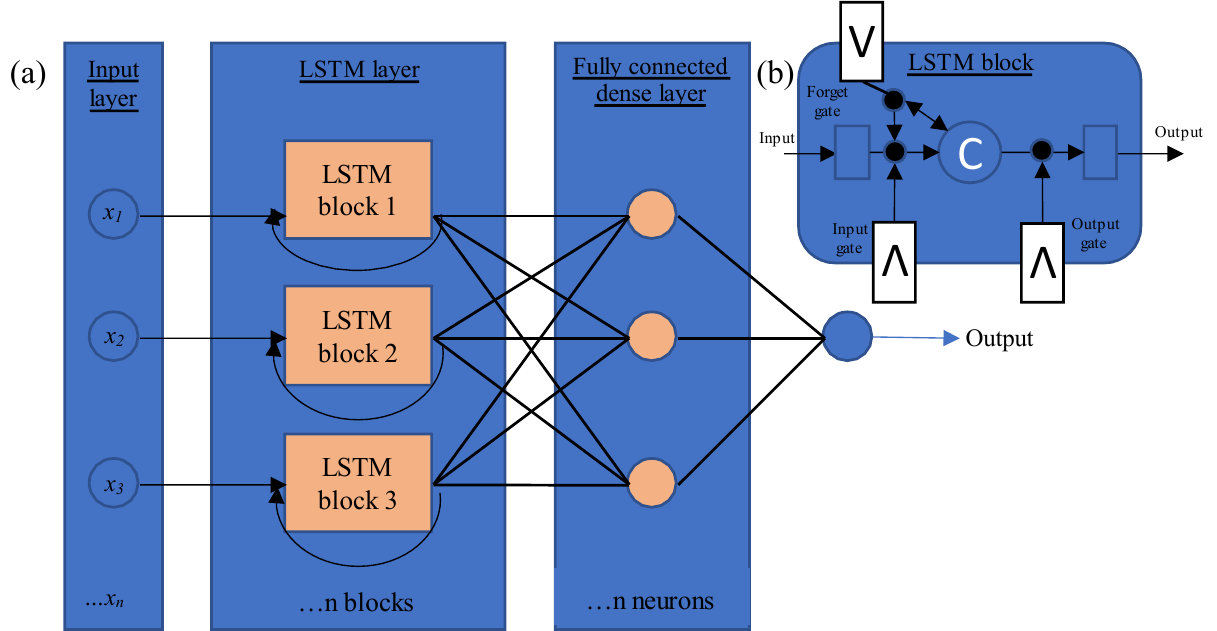
Figure 3: ( a ) simple schematic of an LSTM based architecture. Indicated is the input layer with input vectors x 1 − x n . The hidden layer is in the middle, with the LSTM blocks. Followed by a single fully connected layer providing output; and ( b ) simple internal schematic of an LSTM block. Here the input, output, and forget gates control the flow of information into and out of the memory cell (C).